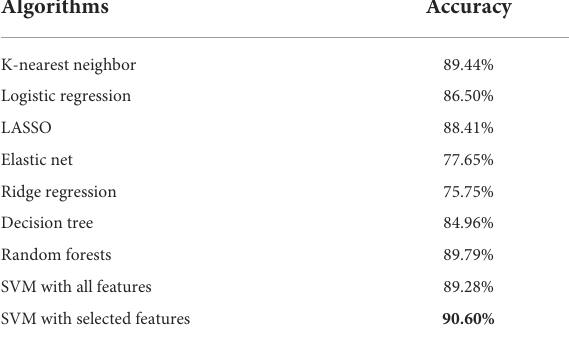
TABLE 3 Average classification accuracy of different algorithms for identifying mood